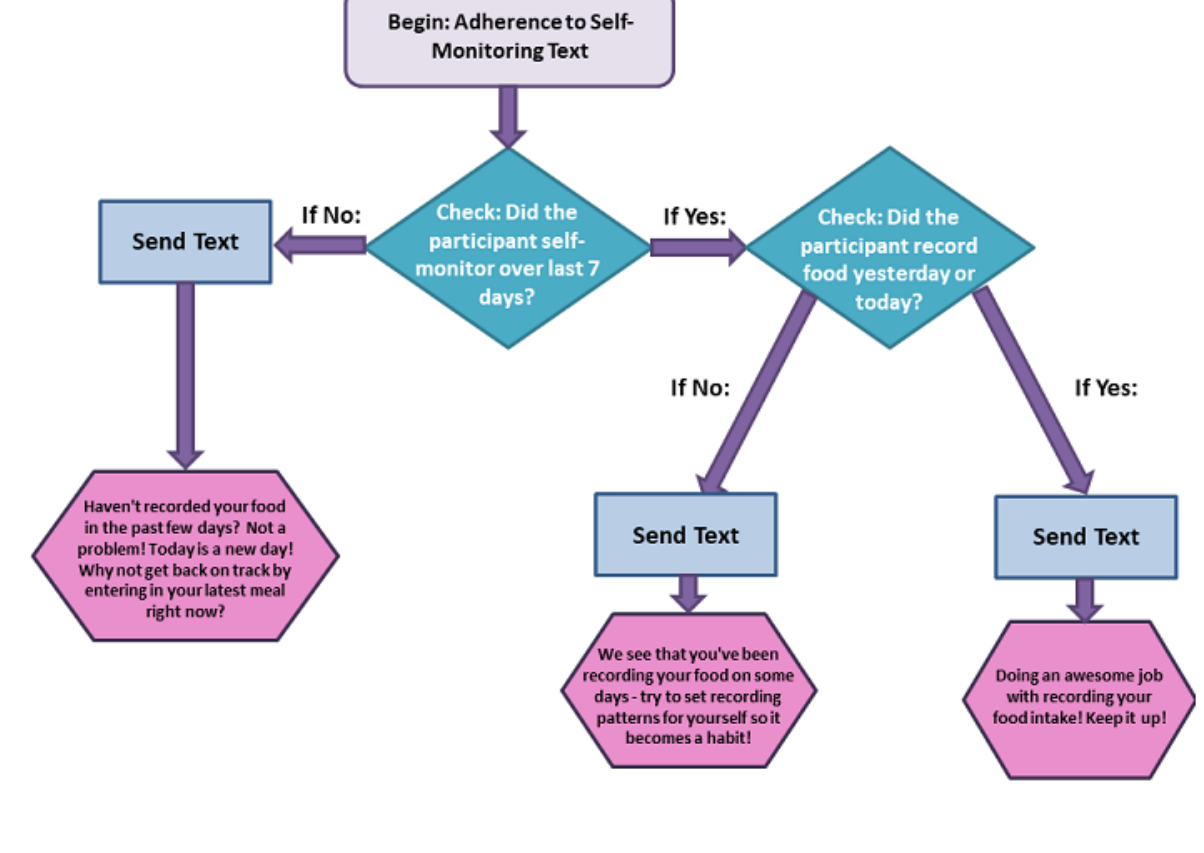
Figure 4. Optimization of Remotely Delivered INtensive Lifestyle Treatment for Obesity Study (Opt-IN) message tailoring: adherence to self-monitoring